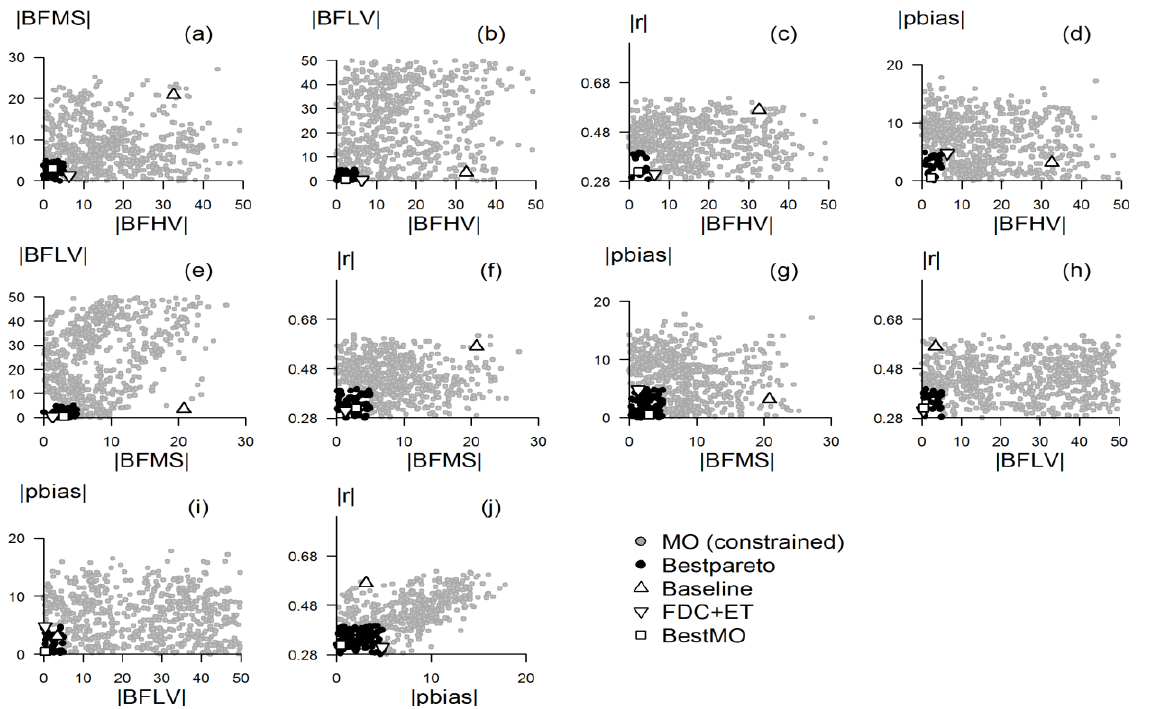
Figure 9. Trade-off in two evaluation criterion spaces for sub-basins 1–18 during the calibration period (2002–2007). The gray dots show all the evaluations in the constrained search (MO (constrained)); the black dots (Bestpareto) represent the best trade-off for the respective bi-criteria with a bias lower than 5% and a correlation higher than 0.65. The upward triangle and downward triangle markers denote evaluations for the baseline and manually calibrated models (FDC + ET), respectively. The square marker represents the selected best trade-off taking into account all the objectives (BestMO).